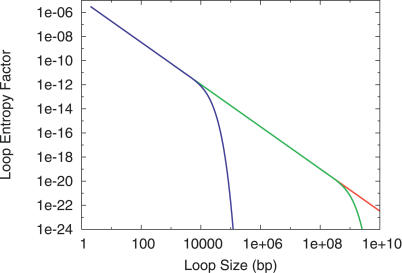
Loop Entropy Factor EstimationThe exact loop entropy factor for σ = 3.5 · 10−5, α = 1.75, and d = 0 is plotted (red) as a function of loop size, together with two Fixman–Freire approximations: a 10-exponentials approximation (blue), which is valid up to loop size about 104, and a 21-exponentials approximation (green), which is valid up to loop size about 108.